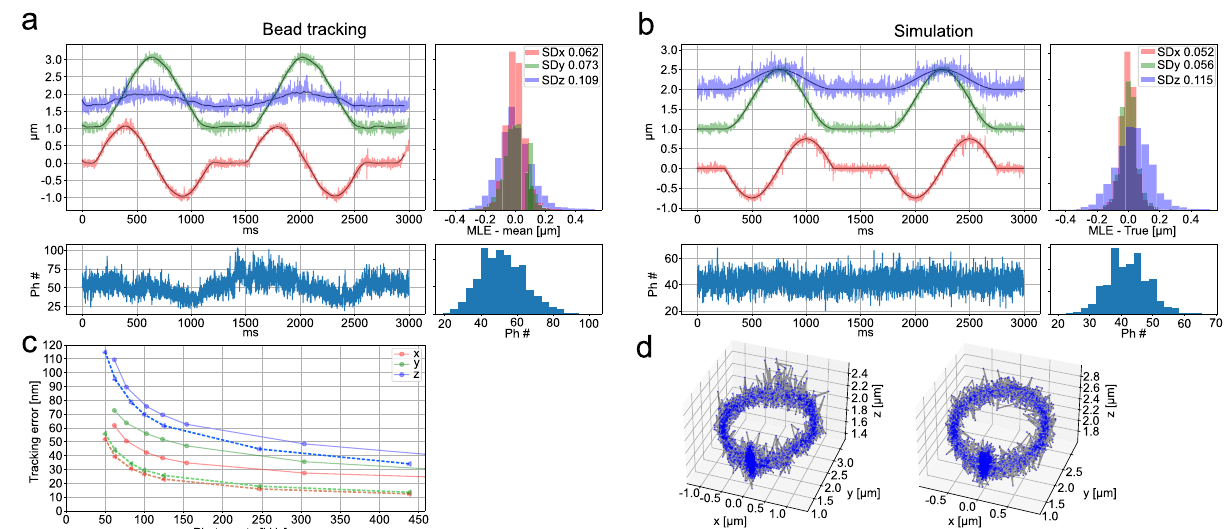
Fig. 2 | Resolutiontestand comparison to simulation. a Tracking ofbeads fi xed inagarose,thepiezostageisprogrammedtotracecircleswithan x , y -radiusof1 μ m and az peak-to-peakoscillationof0.5 μ m.Upper left;Trajectoryestimated x (red), y (green) and z (blue) coordinates with a temporal resolution of 0.84ms. Upper right; distribution of SD over the trajectory between estimation and a moving average with a window size of 100 points. Bottom left; photon counts per locali- zation which corresponds to 60kHz photon count rate. To the right is the photon countdistribution. b Similarto a butforasimulatedtrajectorywithan x , y -radiusof